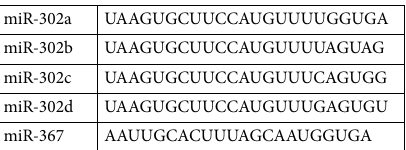
Table 1. Sequences of the miR-302 family members and miR-367.